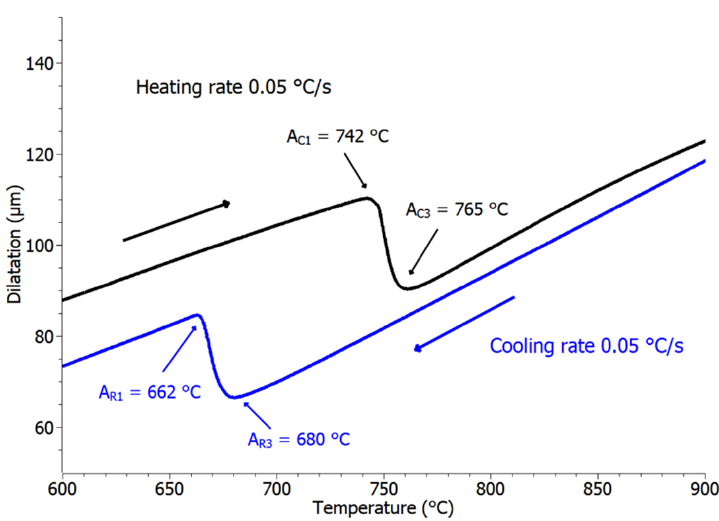
Figure 4. Determination of transformation temperatures at 0.05 °C/s heating and cooling rate.